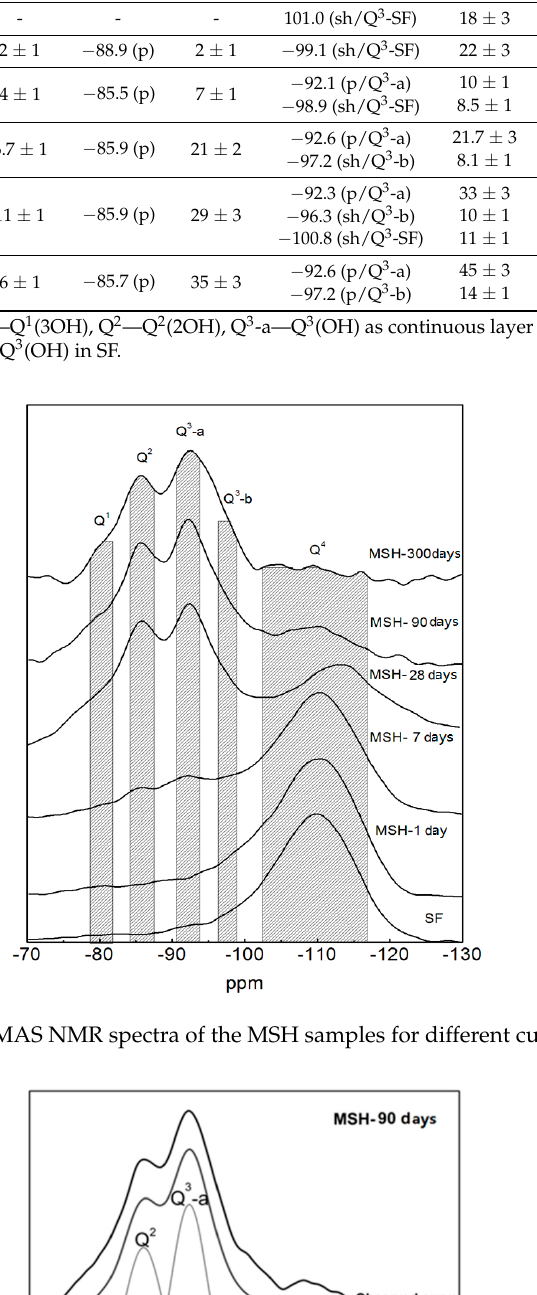
Table 4. 29 Si nuclear magnetic resonance (NMR) chemical shifts (ppm) and relative intensities (%) from de-convolution of the 29 Si MAS NMR spectra for the MSH samples *.